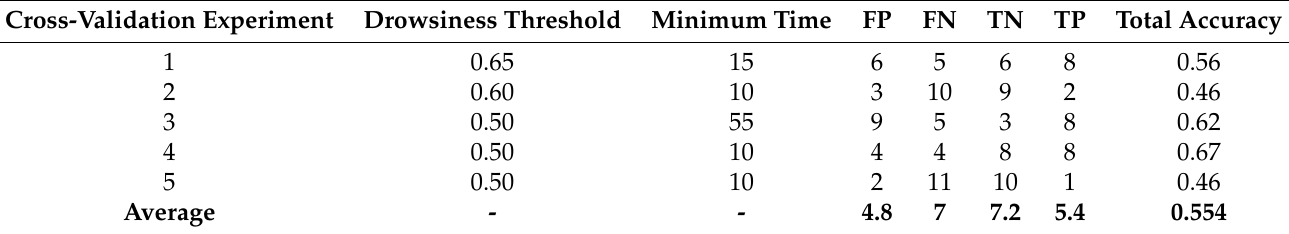
Table 6. Cross-validation of the results obtained by Alternative I over test